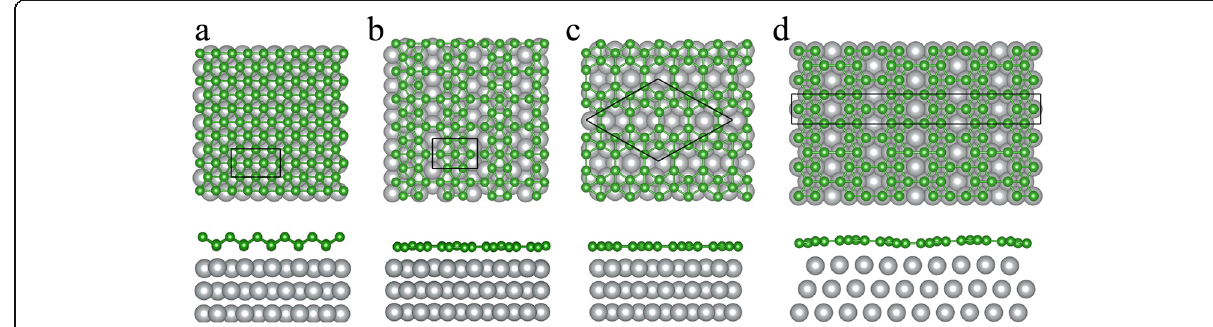
Fig. 4 Top and side views of boron sheets on Ag(111) surface. a Buckled triangular, b β 12 , c χ 3 , and d χ 3 ’ boron sheet. The green and gray balls represent boron and silver atoms, respectively. The rectangles and rhombus enclosed by solid black lines denote the unit cells of boron sheets on the Ag(111) surface mismatches between the unit cells of borophene and 5d indicates that the bright spots come from the p orbit of z upper boron atoms. Figure 5b shows rows of dark round for buckled triangular boron sheet on Ag(111) surface. It spots surrounded by bright hexagons. Obviously, the hex- agonal vacancies in β lattice shown in Fig. 1b result in the 12 very well with experimental observations [22]. Comparing dark spots, while the bright hexagons correspond to the σ orbits of boron atoms around the hexagon holes as shown in Fig. 5e. As shown in Fig. 5c, the χ sheet displays rhombo- 3 led triangular boron sheet on the Ag(111) surface increases hedra pattern of bright spots in dumbbell shape. These to three times. And the shape changes to spindle from bright dumbbell spots actually are the p orbits of the two z round. The STM image of β boron atoms and the σ orbits formed between them. sheet on Ag(111) surface 12 shown in Fig. 5h shows rows of dark oval spots surrounded patterns relative to the freestanding ones because of the by four bright spots on its four corners. Different from the